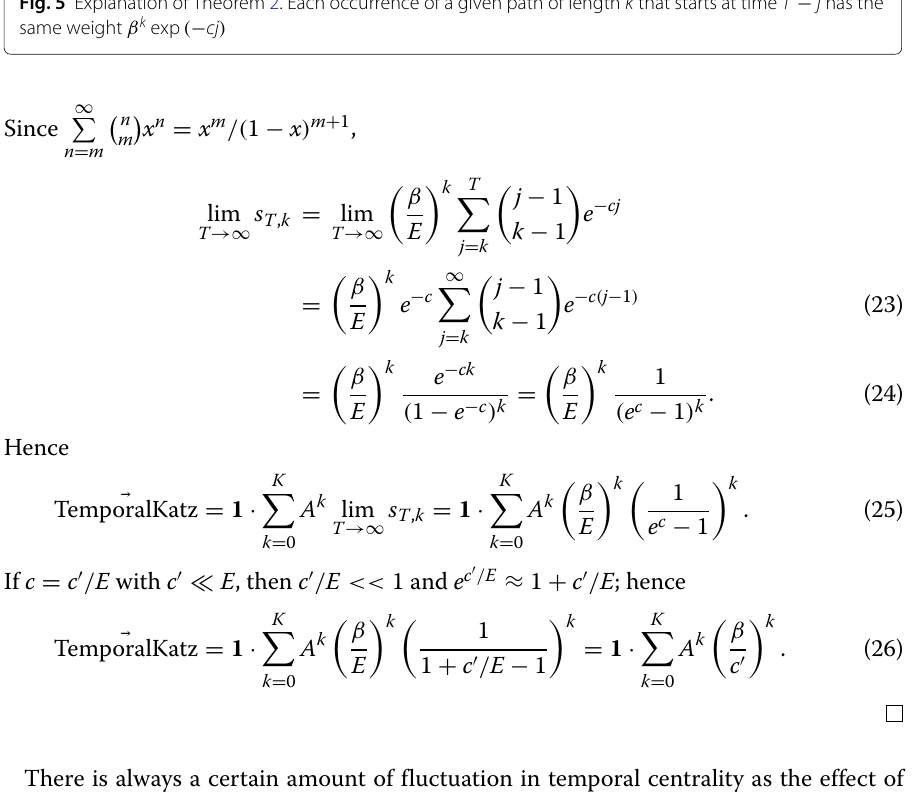
Fig. 5 Explanation of Theorem 2. Each occurrence of a given path of length k that starts at time T − j has